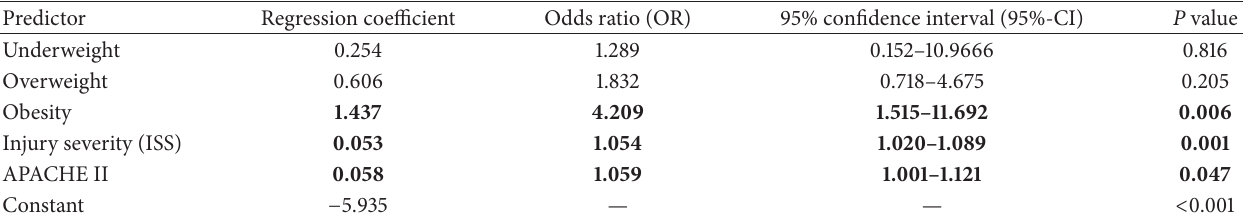
Table 5: Multivariate regression analysis referring to MODS analyzing BMI, injury severity (ISS), and APACHE II score as potential predictors.